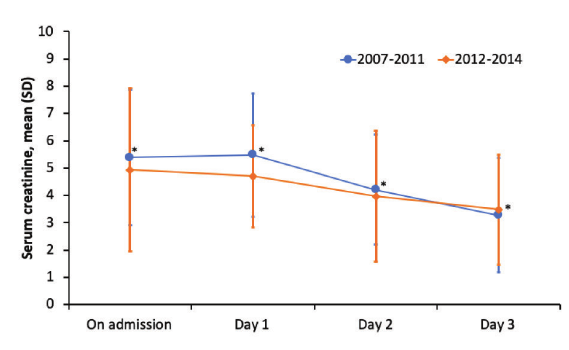
Figure 1. Comparison of serum